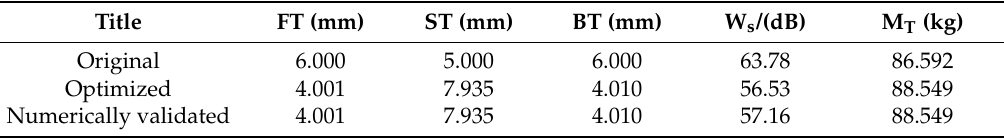
Table 6. The multi-objective optimization